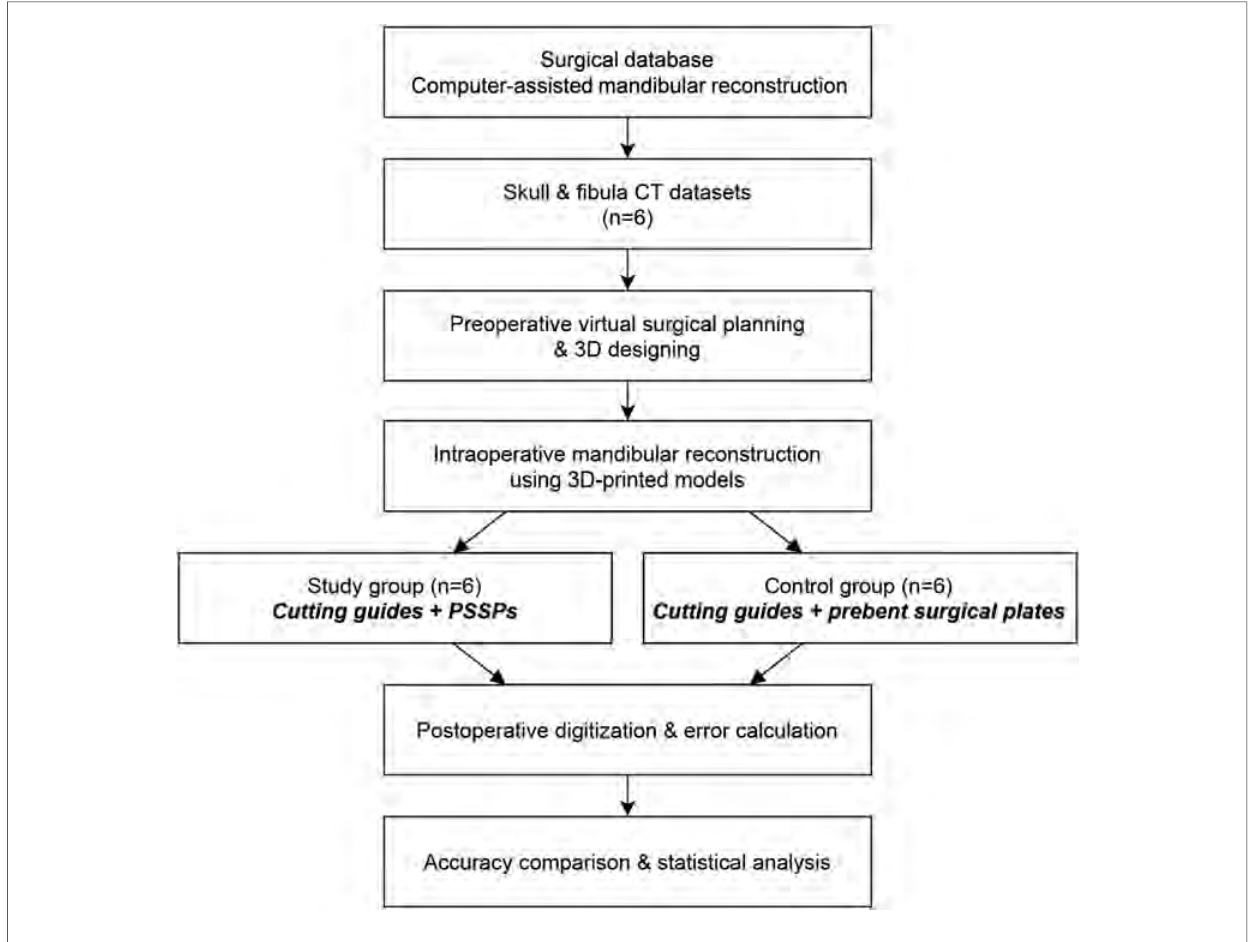
FIGURE 1 Schematic of study